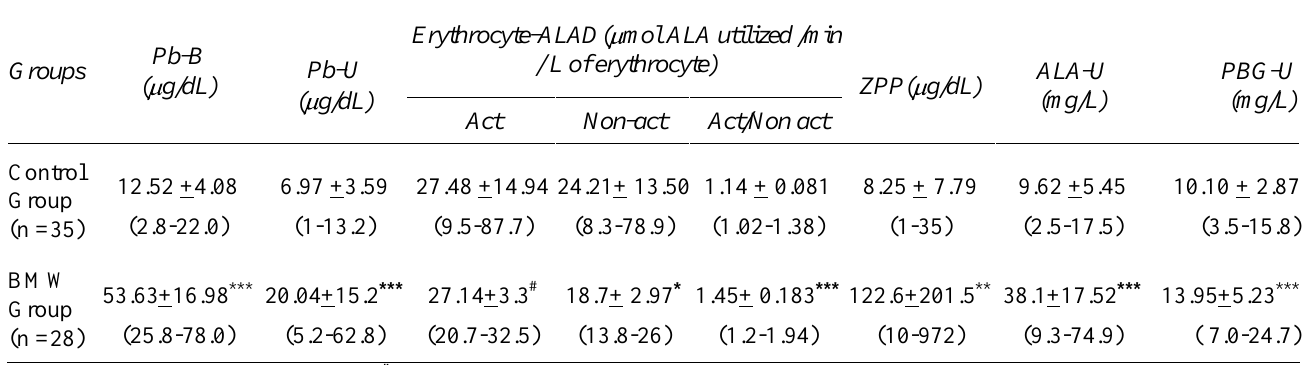
Table 1: Pb-B, Pb-U and parameters related to heme biosynthesis in study group and control group Erythrocyte-ALAD( mol ALA utilized /min